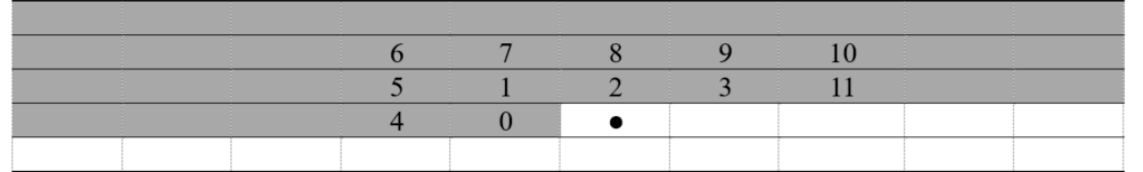
Figure 3. An example of SOC.